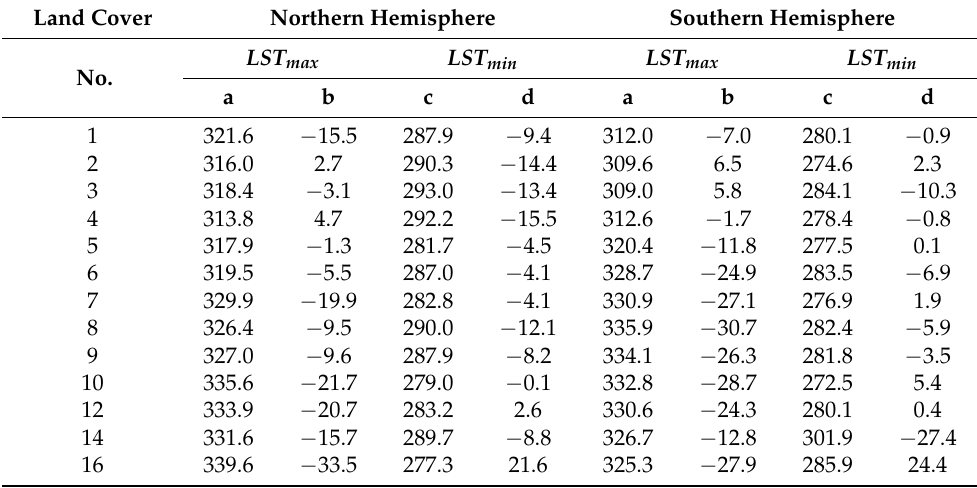
where a , b , c , d are the coefficients determined for LST max and LST min using real LST and NDVI data. This study used the GK-2A L2 LST and NDVI products. Table 3 shows the coefficient values of LST max and LST min according to the land cover on 19 July 2020. Table 3. Coefficients of LST max and LST min Table 3. Coefficients of 𝐿𝑆𝑇 𝑚𝑎𝑥 and 𝐿𝑆𝑇 𝑚𝑖𝑛 .